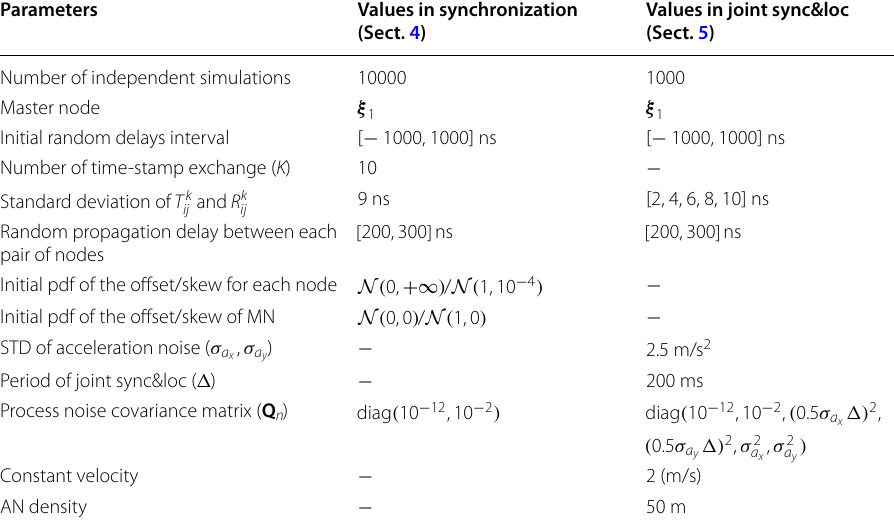
Constant velocity AN